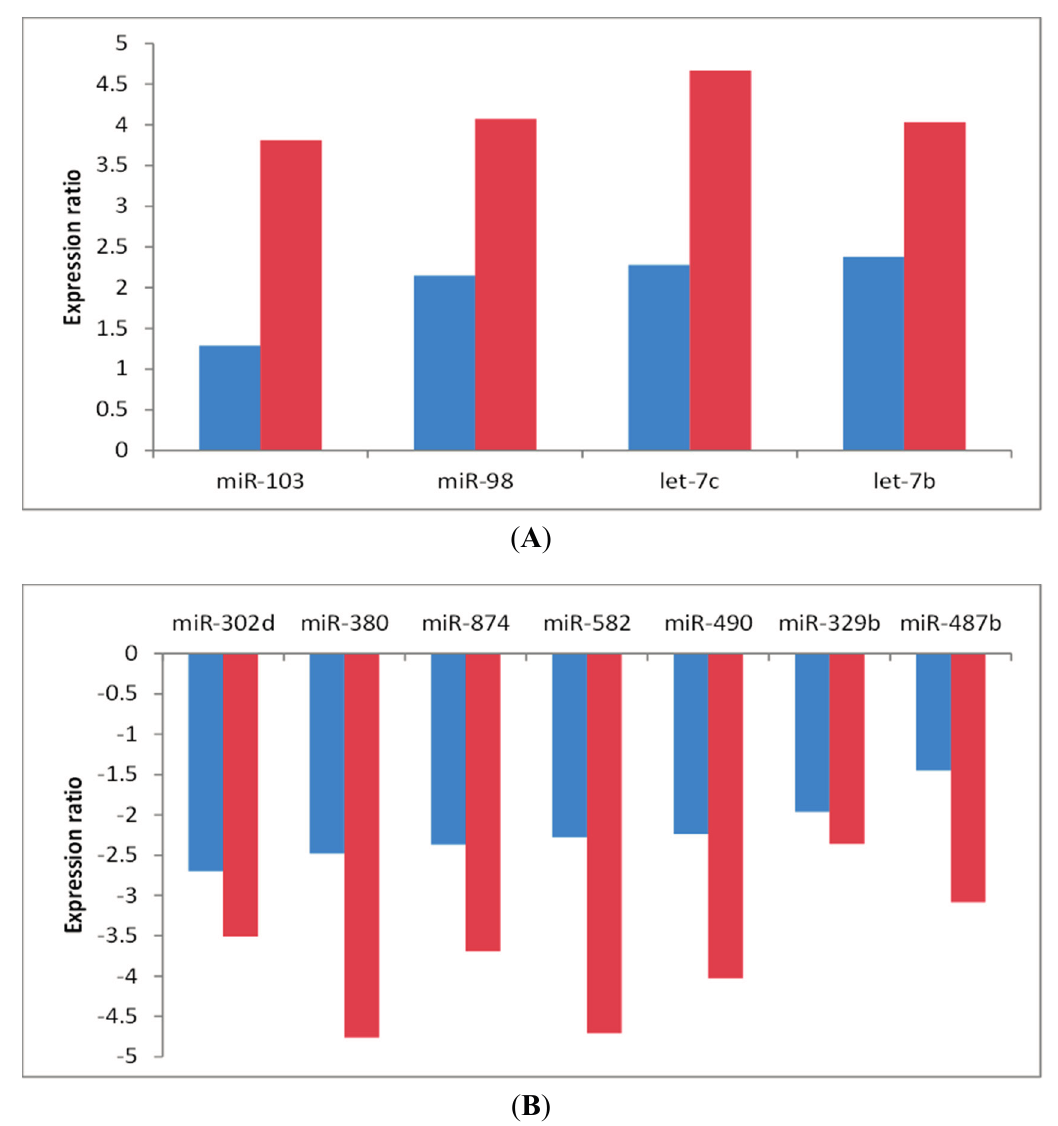
Figure 1. Expression ratios of differentially expressed microRNAs in the serum of dogs with myxomatous mitral valve disease (MMVD). Groups of six dogs each included normal dogs at risk of heart disease (Stage A), asymptomatic dogs with MMVD and mild to moderate cardiac enlargement (Stage B1/B2) and dogs with MMVD and congestive heart failure requiring multiple cardiac medications (Stage C/D). ( A ) shows miRNAs upregulated in dogs with stage B1/B2 or stage C/D compared to stage A; and ( B ) shows miRNAs downregulated in dogs with stage B1/B2 or stage C/D compared to stage A. Blue bars indicate the changes in stage B1/B2 and red bars indicate the changes in stage C/D, compared to stage